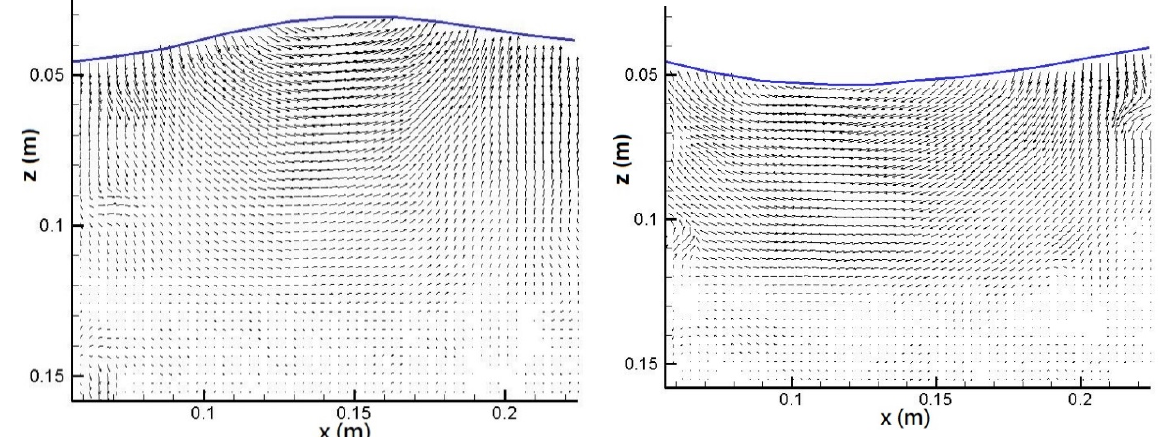
Figure 15. Velocity distribution of a short-period wave ( T = 0.5 s) around vegetation region ( ϕ = 0.5 cm and d = 5 cm).